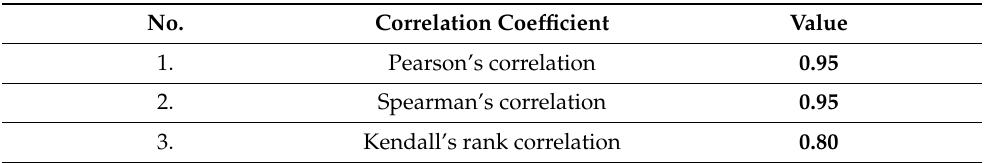
Table 7. Statistical correlation between forecasted observation-based and simulation-based Lhasa River discharge, 2017–2025.